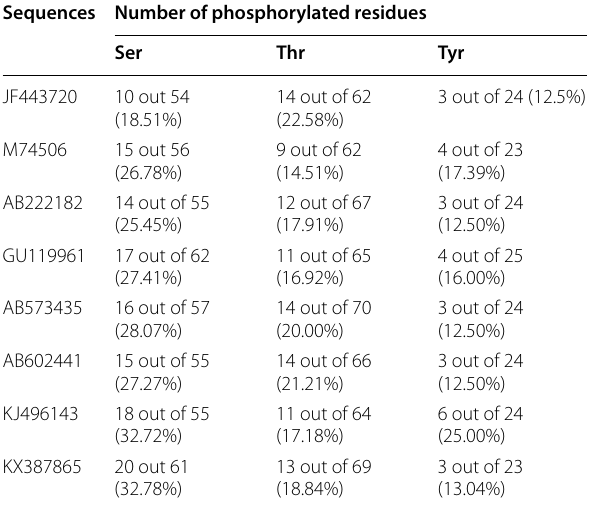
Table 5 Predicted number and percentage of phosphorylated residues in ORF2 of hepatitis E viruses Sequences Number of phosphorylated